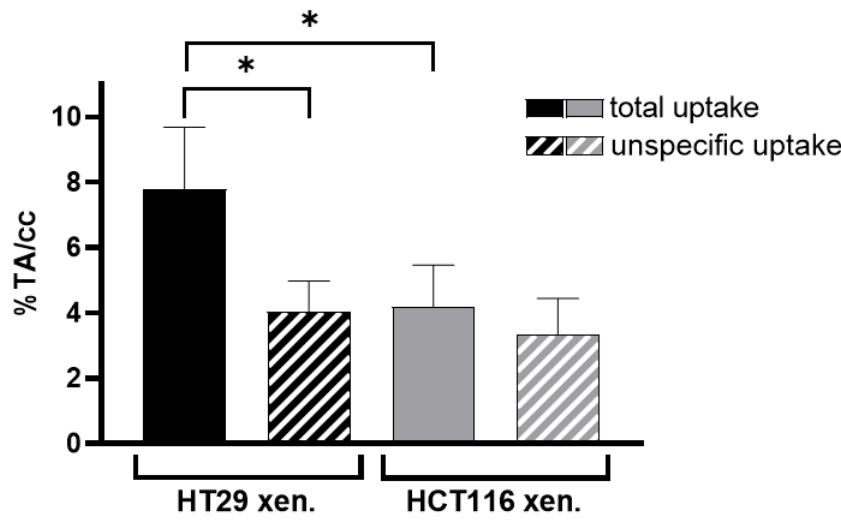
Figure 2. Total and unspecific uptake of [ 68 Ga]Ga-Pentixafor in HT29 CAM-xenografts and HCT116 CAM-xenografts. Unspecific uptake was determined by co-injection of an excess of AMD3100 (blocking condition). Experiments were performed using at least three different individuals ( n ≥ 3). For HCT116 CAM-xenografts, 8 paired datasets were obtained (baseline: n = 9, blocking: n = 8). For HT29 CAM-xenografts, longitudinal scanning was possible only with two subjects (baseline: n = 7, blocking: n = 3). The use of paired and unpaired datasets was considered in the statistical analysis. The total number of counts in the egg (extracted from a spherical VOI covering the whole subject) was taken as the total activity. Data are plotted as percentage of total activity per cm 3 (%TA/cc) and presented as mean ± SD. Datasets that are significantly different ( p < 0.05) are marked with an asterisk (*).